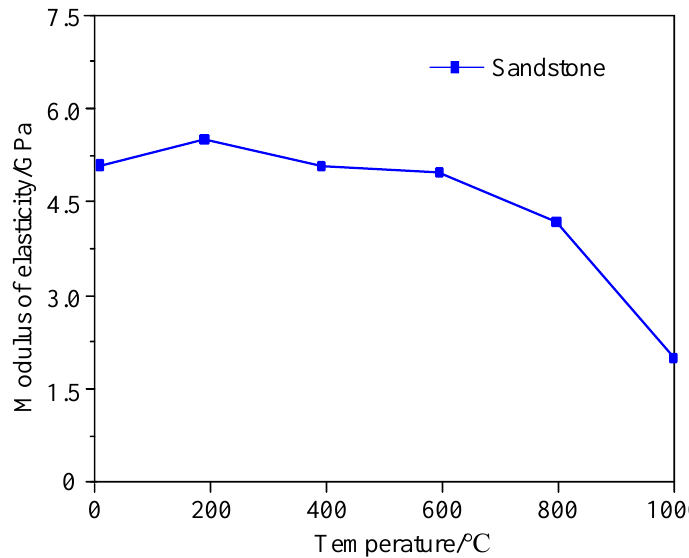
Figure 7. Variation curve of modulus of elasticity of sandstone with temperature.